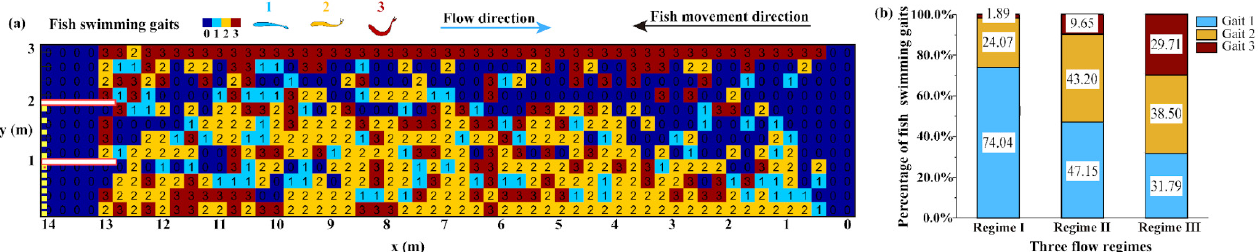
Figure 6. Quantification of fish swimming gaits in the swim test area: ( a ) heatmap of the maximum gait value in each cell employed by the swimming fish; ( b ) percentage of the different fish swimming gaits in the three flow regimes.